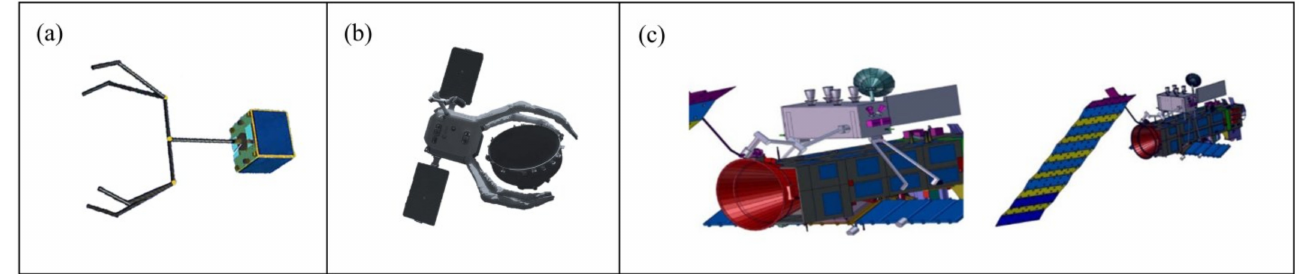
Figure 8. Project scheme: ( a ) space debris micro-remover, JAXA [165]; ( b ) “Pac-Man”, Clearspace-1, ESA [167]; ( c ) e. Deorbit’s follow-up research